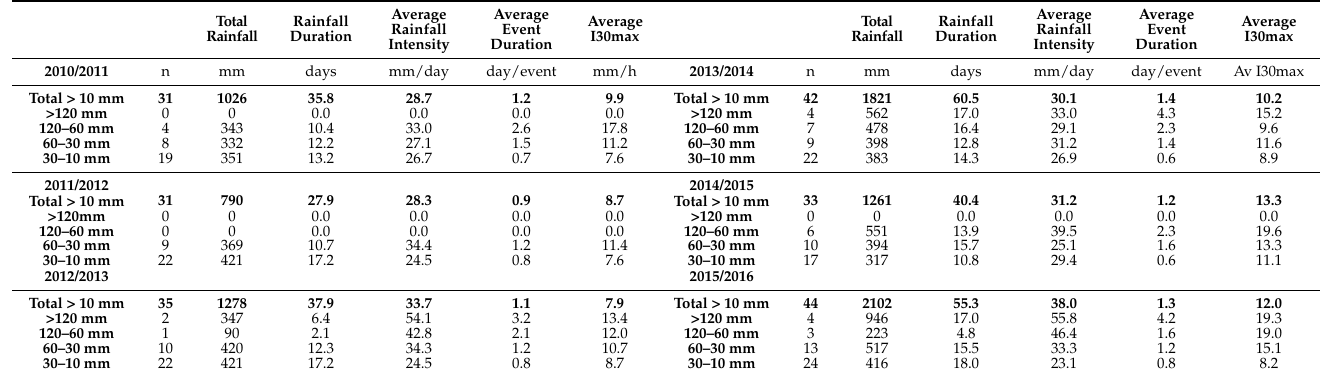
Table 3. Characterization of rainfall events per event